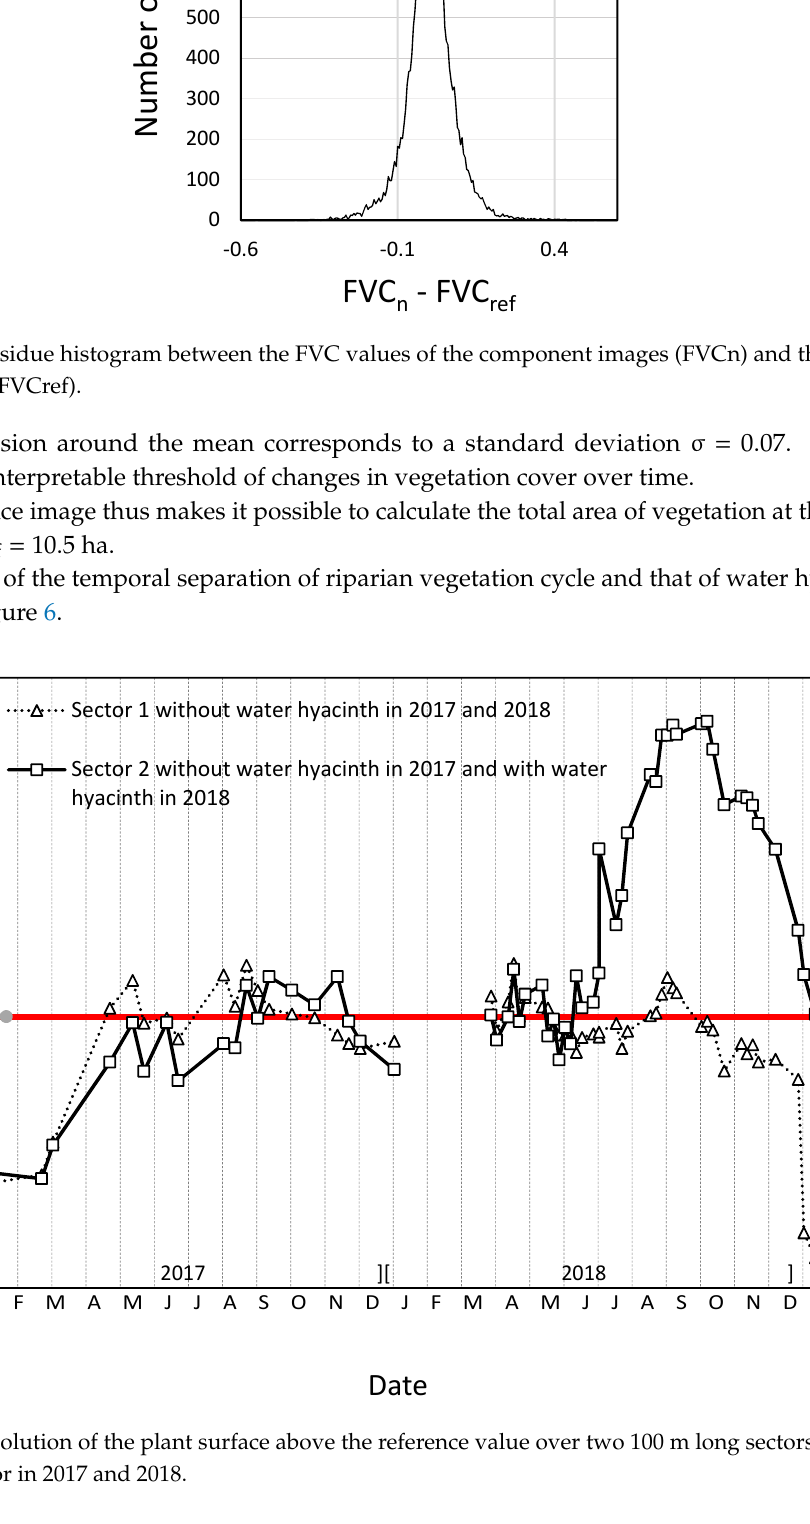
Figure 6. Evolution of the plant surface above the reference value over two 100 m long sectors in the river corridor in 2017 and 2018.